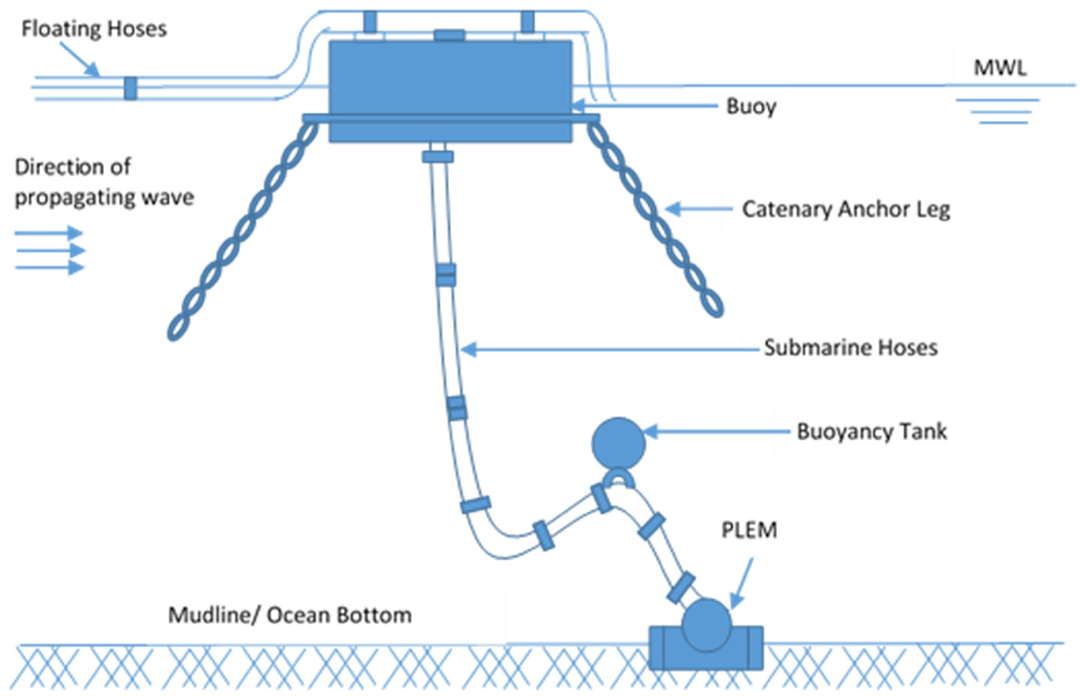
Figure 11. An illustration of Steep-S hose configuration.